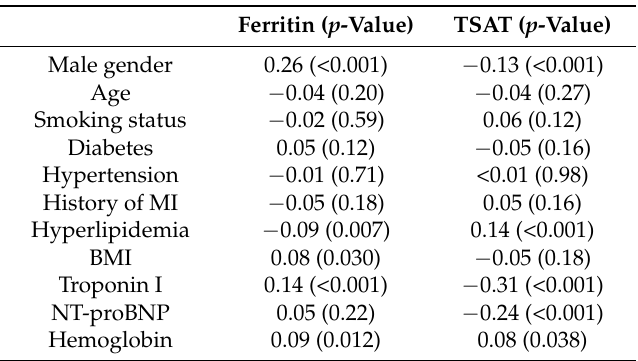
Table 2. Partial Spearman rank correlation